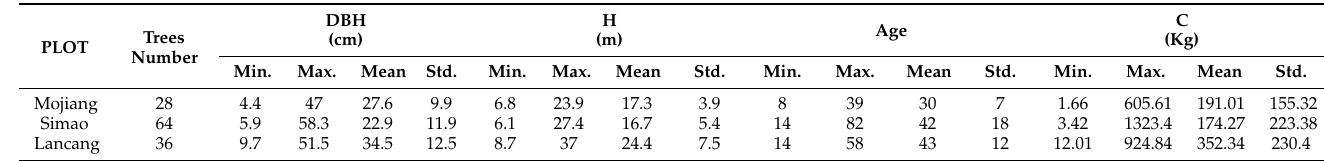
Table 2. Descriptive statistics of sample trees used in this study.